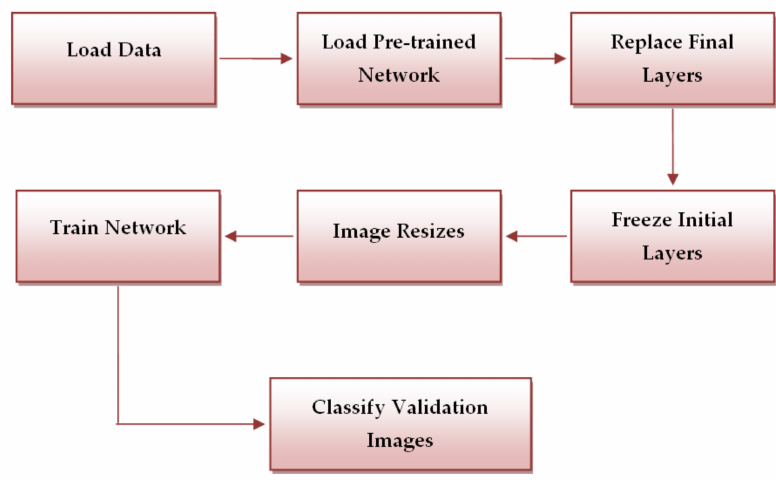
Figure 6. Workflow of CNN-based